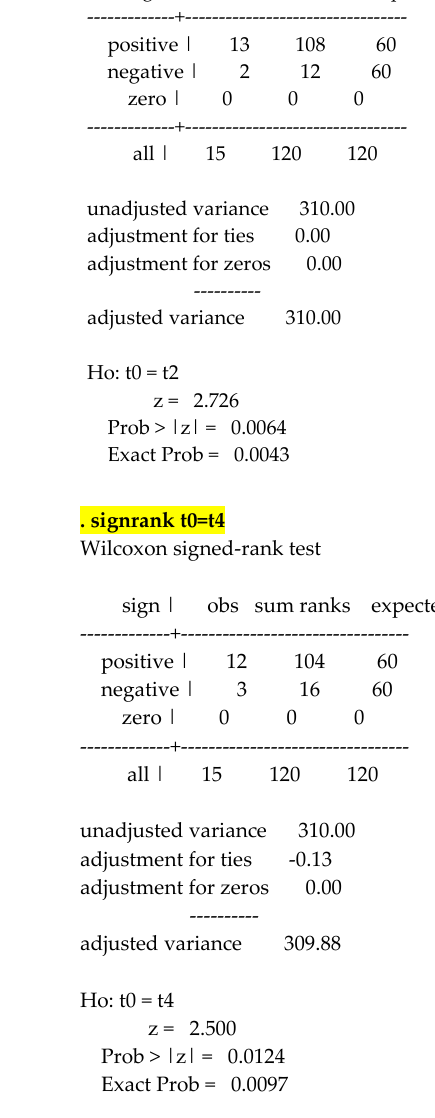
Figure 2. Friedman’s nonparametric two-way analysis of variance. Post-hoc analysis with Wilcoxon Figure 2. Friedman ’ s nonparametric two-way analysis of variance. Post-hoc analysis with Wilcoxon signed-rank test with signed-rank test with Bonferroni.